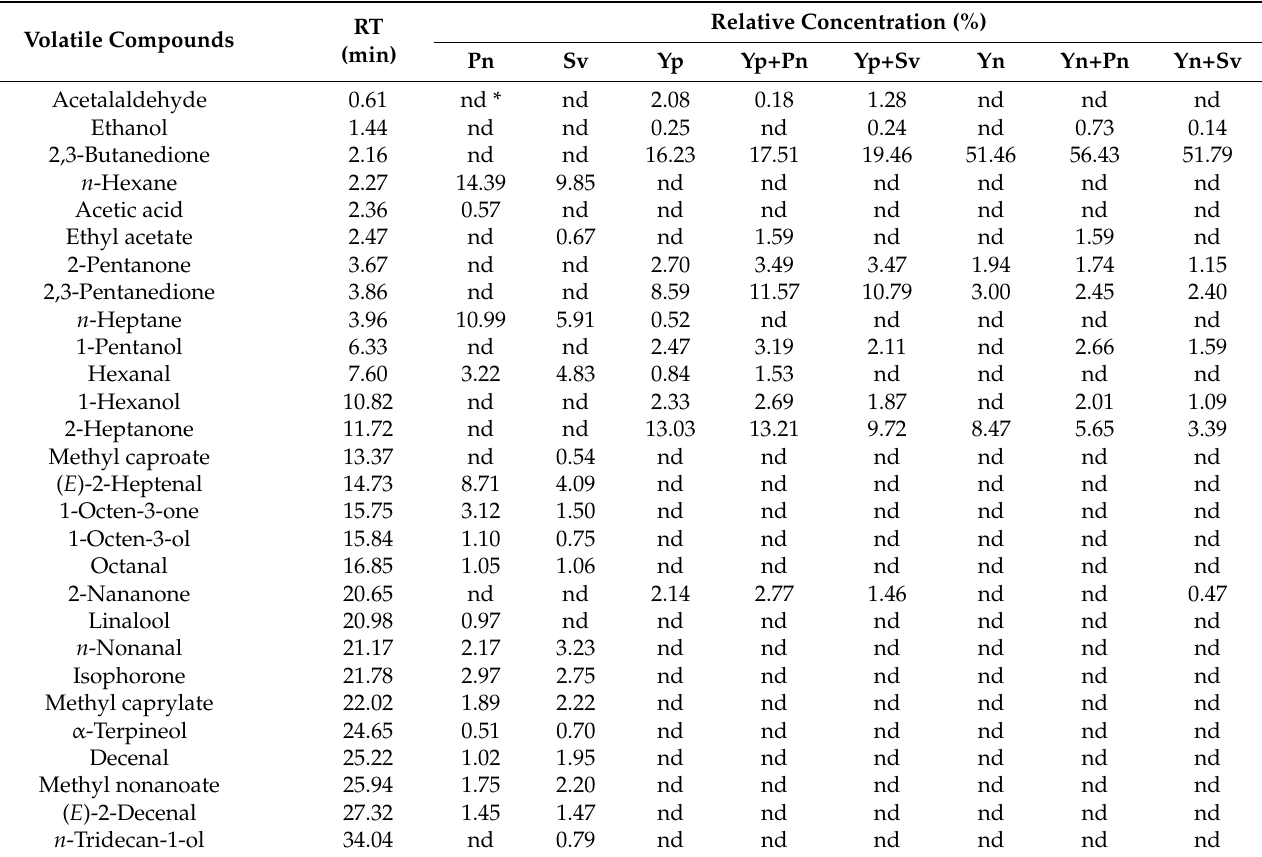
Table 10. The main volatile compounds detected in probiotic (Yp) and natural (Yn) yogurt with or without scCO 2 /H 2 O extracts from P. nigra (Pn) and S. viminalis